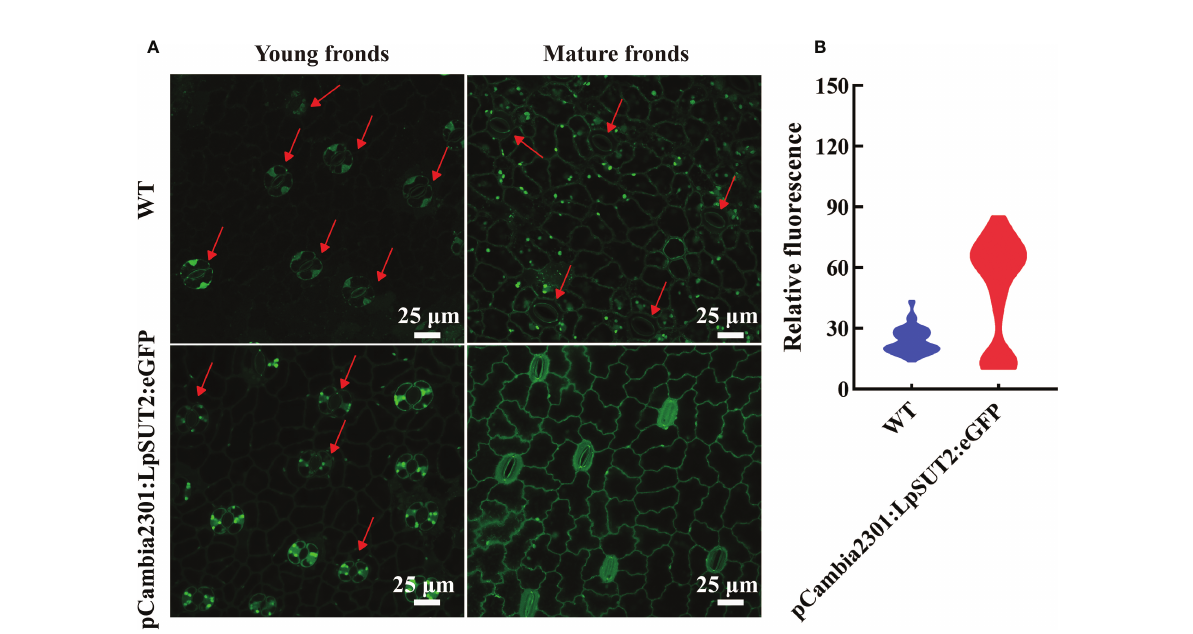
FIGURE 8 Detection of ROS accumulation in guard cells. The content of ROS in guard cells of young and mature fronds was detected in overexpressed lines and WT lines, respectively (A) . These results indicated that ROS content increased signi fi cantly and stomatal conductance decreased in guard cells of overexpression lines compared to that of WT lines (A) . The relative fl uorescence intensity of at least 40 guard cells was quanti fi ed with a laser scanning confocal microscope (B) . The red arrow points to the guard cell. Scale bars: 25 m m in (A) . ROS, Reactive oxygen species; WT, Wild